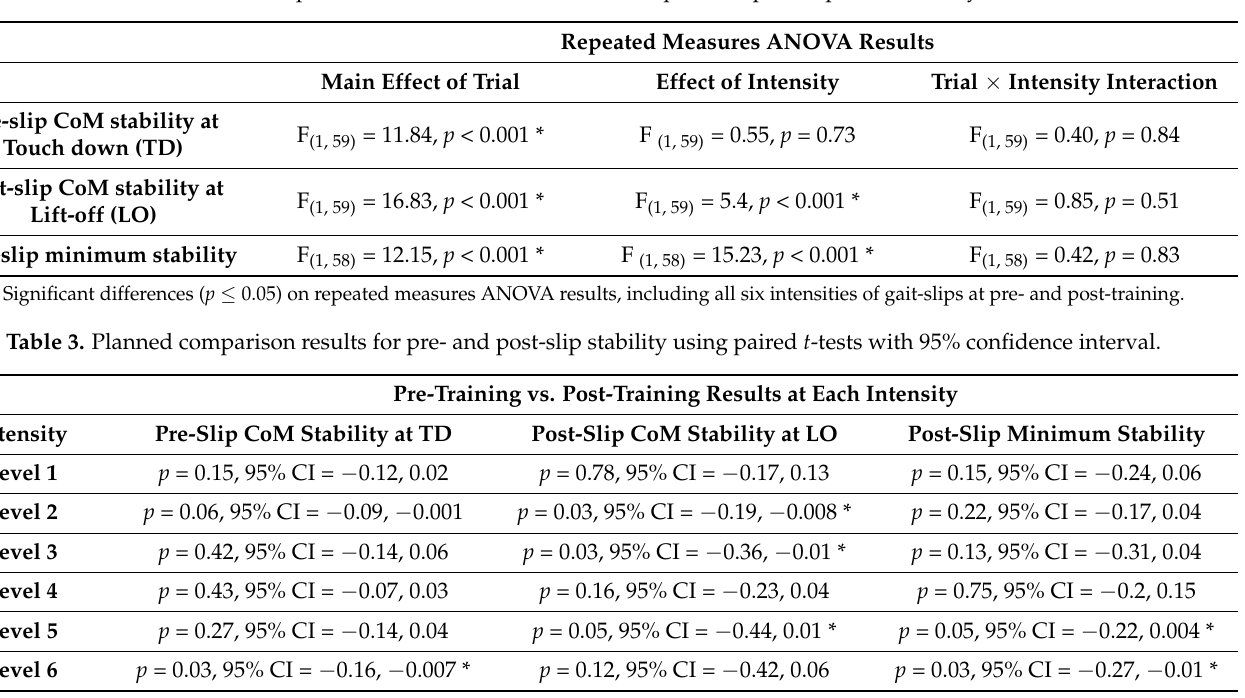
Table 2. Repeated measures ANOVA results for pre- and post-slip CoM stability.